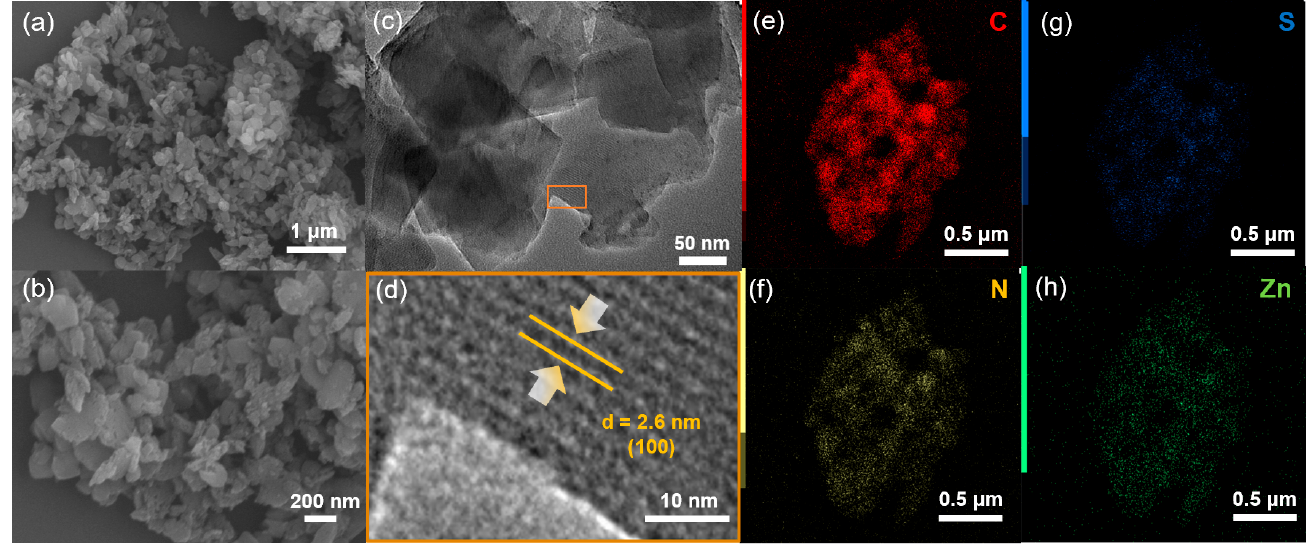
Figure 4. ( a , b ) SEM and ( c , d ) TEM images of Zn-Por-TT COF; ( e – h ) elemental maps of Zn-Por-TT COF.